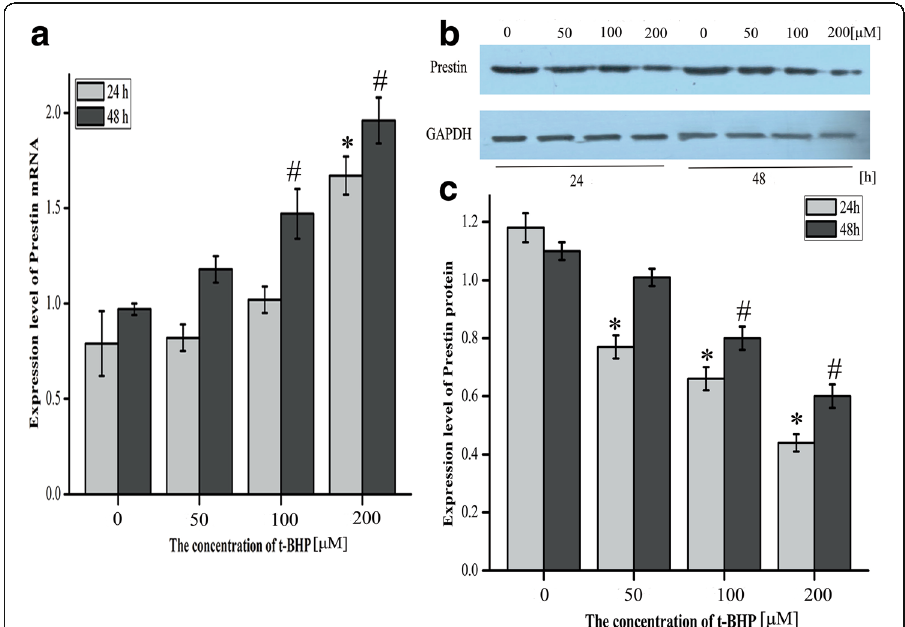
Fig. 1 Expression level of Prestin in HEI-OC1 cells treated with t-BHP for 24 h and 48 h. a Expression level of Prestin mRNA in HEI-OC1 cells exposed to different concentrations of t-BHP (0 μ M, 50 μ M, 100 μ M, 200 μ M) for 24 h and 48 h. b Representative western blot of Prestin from cells treated with t-BHP. GAPDH was used as an endogenous control. These images came from the same gel. c Expression level of Prestin protein in HEI-OC1 cells exposed to t-BHP. The data were normalized to GAPDH expression, and they were presented as the means±SD; n = 3 each group. * and # represent P < 0.05 compared with the control